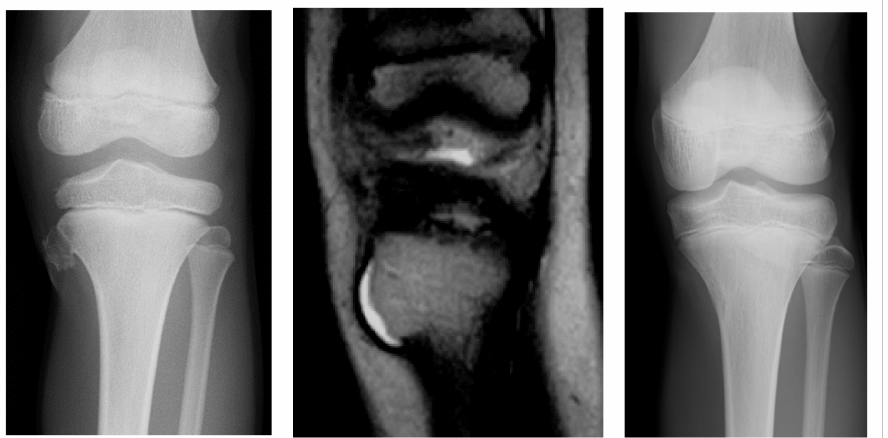
Figure 2. A radiograph revealing a pedunculated osteochondroma at the proximal tibia (left). The thickness of the cartilage cap is 2.83 mm upon MRI examination (middle). After 6 years, the tumor vanished, as depicted by a radiograph